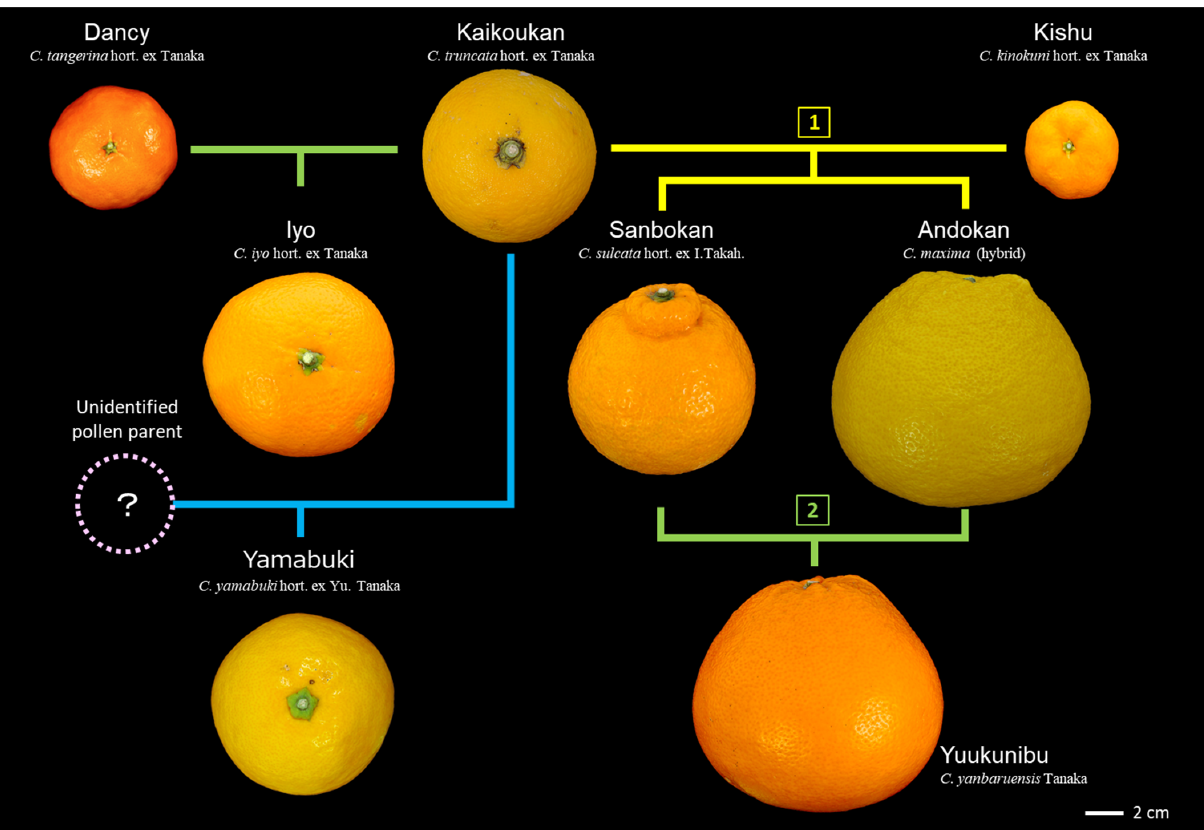
Figure 6. Pedigree of Kaikoukan ( C. truncata hort. ex Tanaka) and Kishu with Dancy. The one in the square indicates the first cross to produce Sanbokan and Andokan, and the two in the square indicate their crossing.